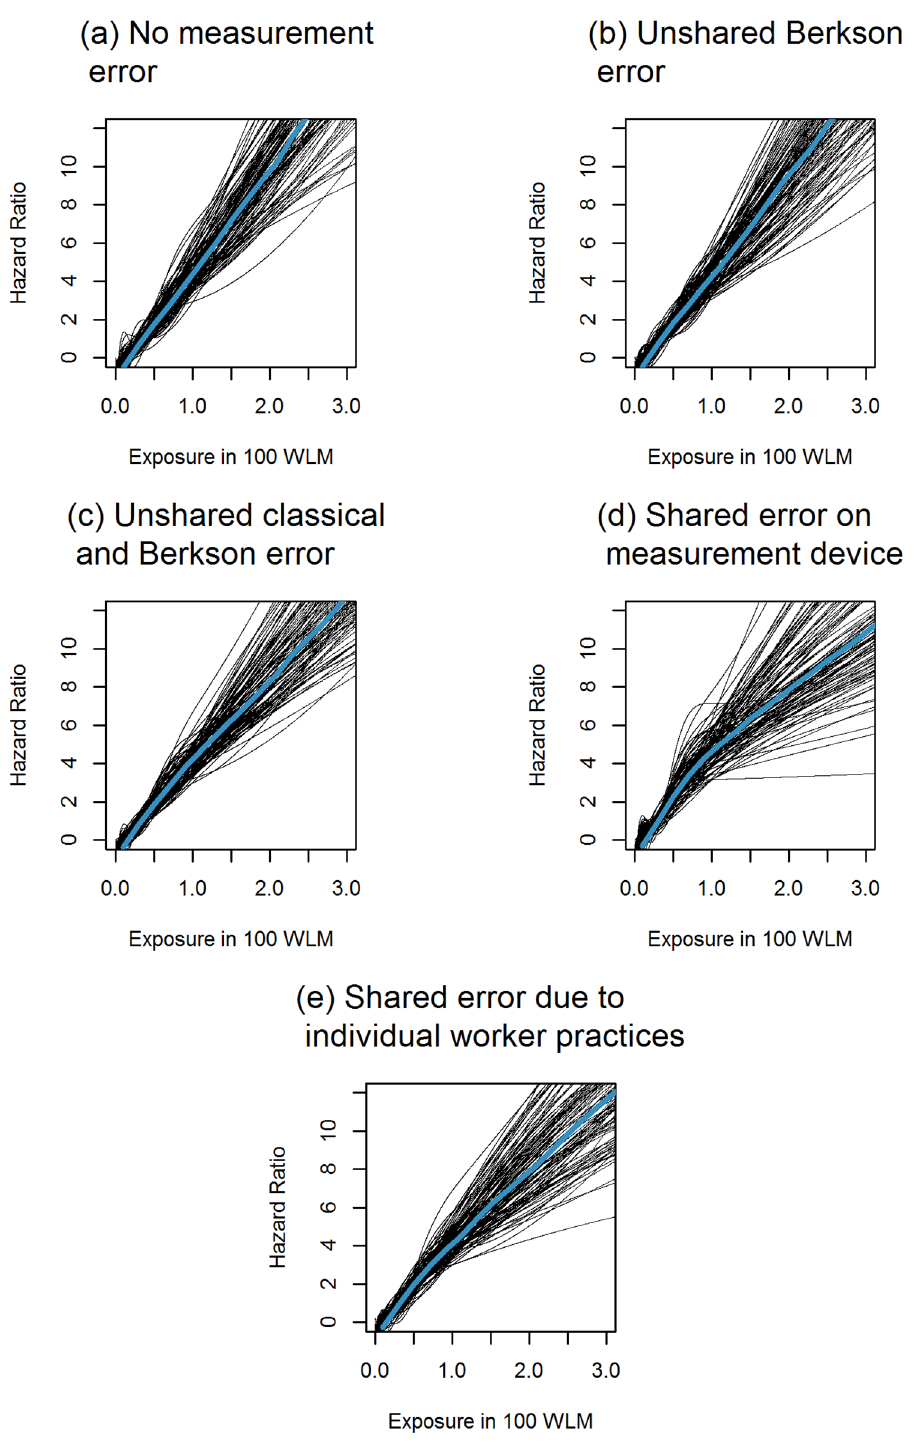
Fig 2. Estimated exposure-response curve when fitting the Excess Hazard Ratio (EHR) model D based on natural 3 cubic splines when data are generated according to the EHR model D with a risk coefficient of β = 5. (a) M , i.e., 0 1 no measurement error (b) M , i.e., unshared and homoscedastic Berkson error, (c) M , i.e., unshared error of 1 9 Berkson and classical type (d) M , i.e., heteroscedastic error with a shared classical component describing the 10 imprecision of the measurement device and (e) M , i.e., heteroscedastic error with a shared Berkson component 11 describing individual worker